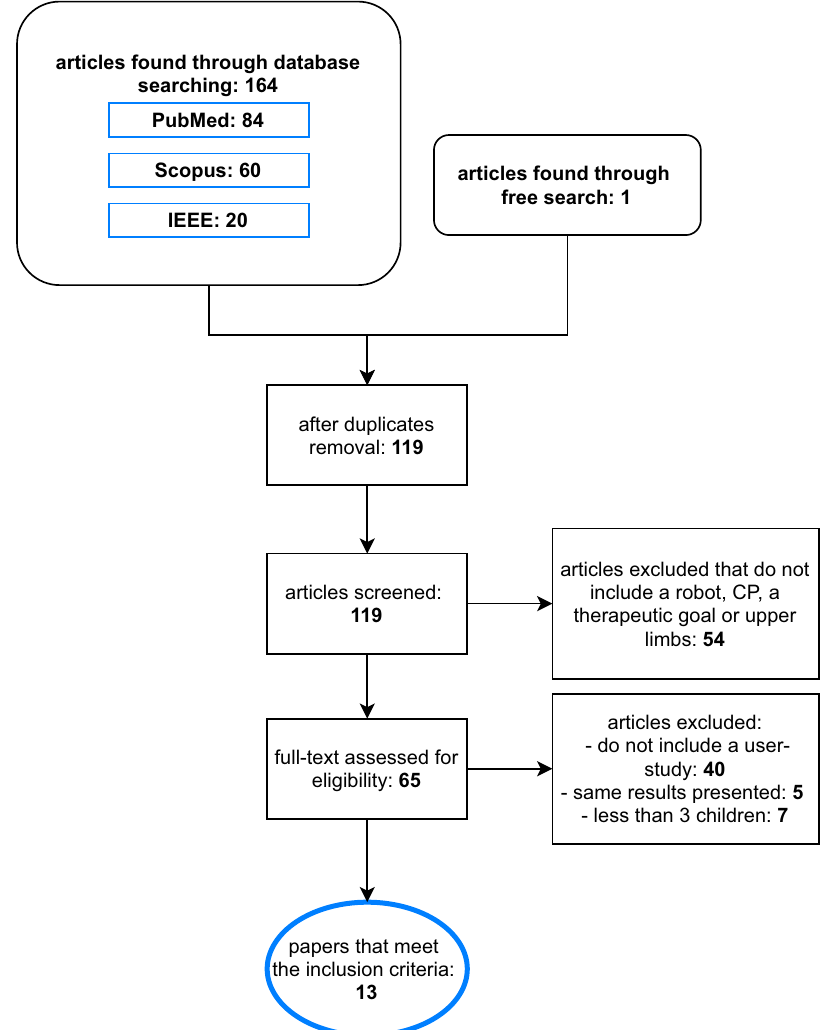
Figure 1: PRISMA Flow diagram of the review